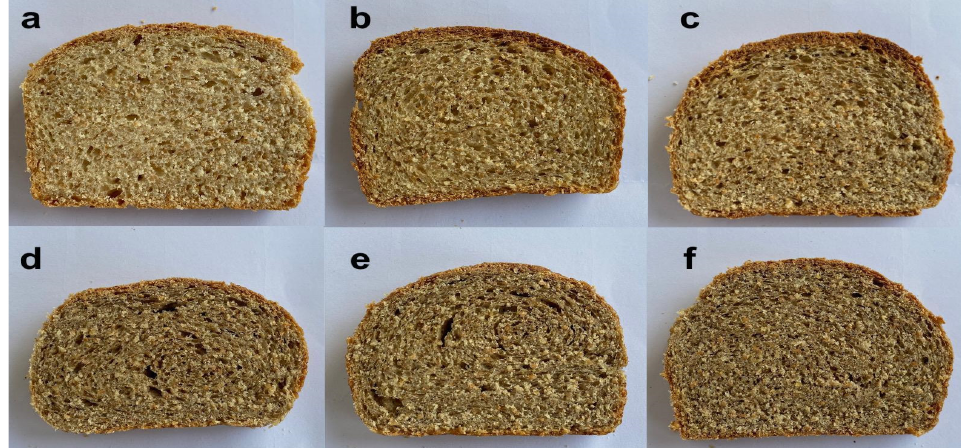
Figure 1. Images of the cross-section of bread slices: ( a ) control, ( b ) enriched bread with 10% cricket powder, ( c ) 15%, ( d ) 20%, ( e ) 25%, and ( f ) 30% by flour weight.